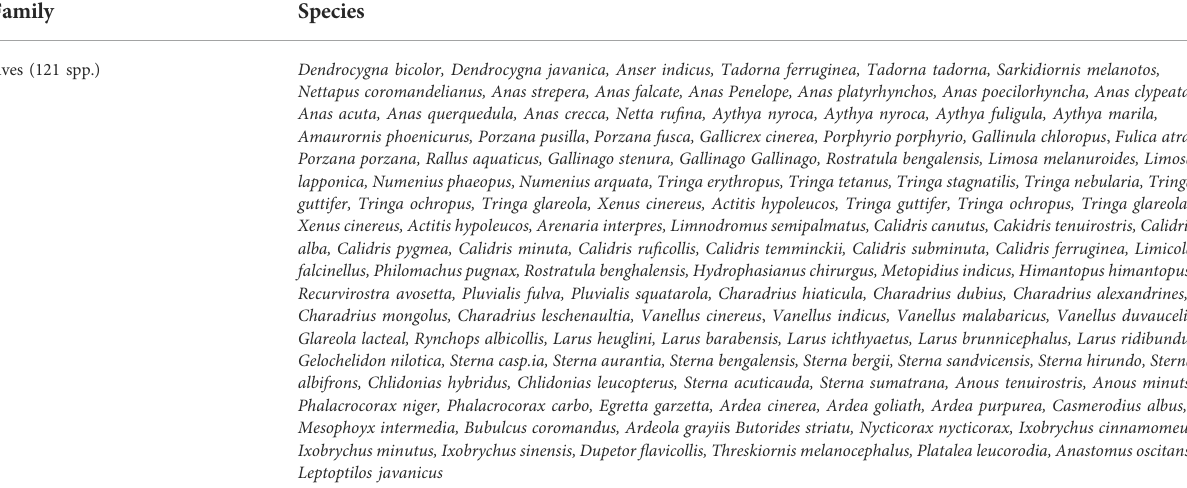
TABLE 10 Diversity of avifauna (121 spp.) in the estuarine waters of Bangladesh. Family Species Aves (121